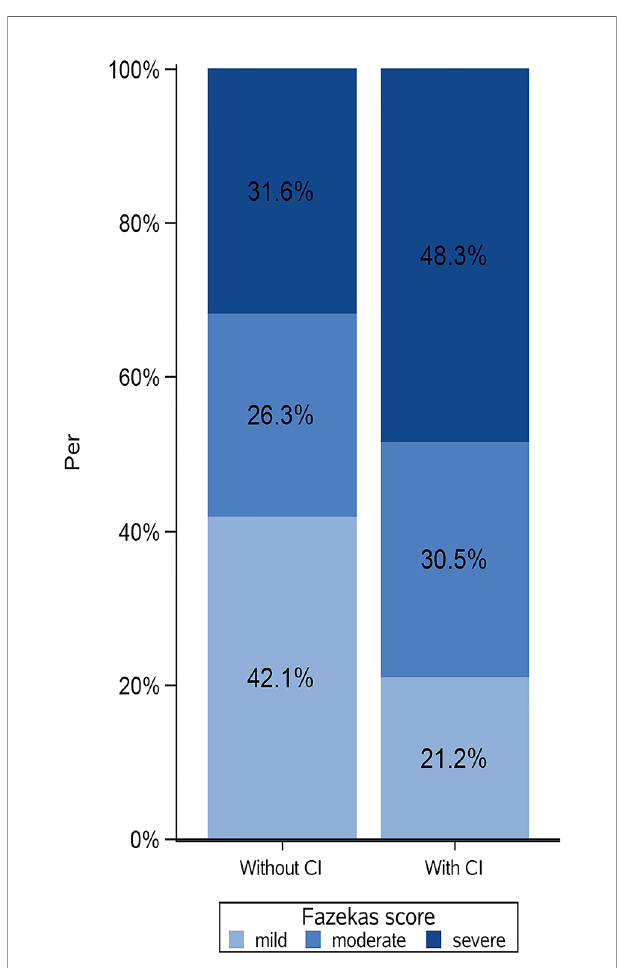
FIGURE 1 | Distribution of white matter hyperintensities (WMH) severity in patients with and without cognitive impairment. CI, cognitive impairment; Fazekas score, mild (Fazekas score=0-2); moderate (Fazekas score=3-4); severe (Fazekas score=5-6). Patients without cognitive impairment could show severe WMH, on contrary, patients with normal cognitive function could show mild WMH.